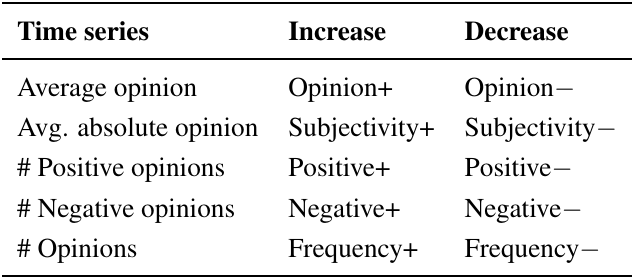
Table 2. The type of a detected opinion event depends on the time series from which it was extracted and the direction of change. For example, an increase of the average opinion has the type